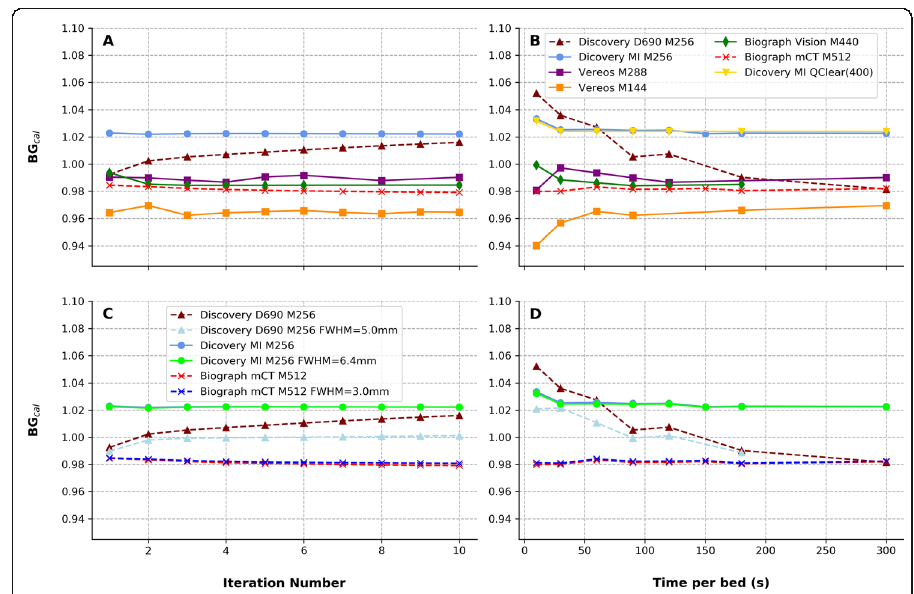
Fig. 1 BG cal as a function of the number of iterations used in the iterative reconstruction setups without Gaussian smoothing ( a ) and comparison of Gaussian vs. non-Gaussian setups ( c ) for devices that used the Gaussian smoothing in the clinic. Similarly, we reported BG cal as a function of the time per bed position ( b and d ). Digital devices were labeled with full lines; dashed lines represent obtained results with analogue